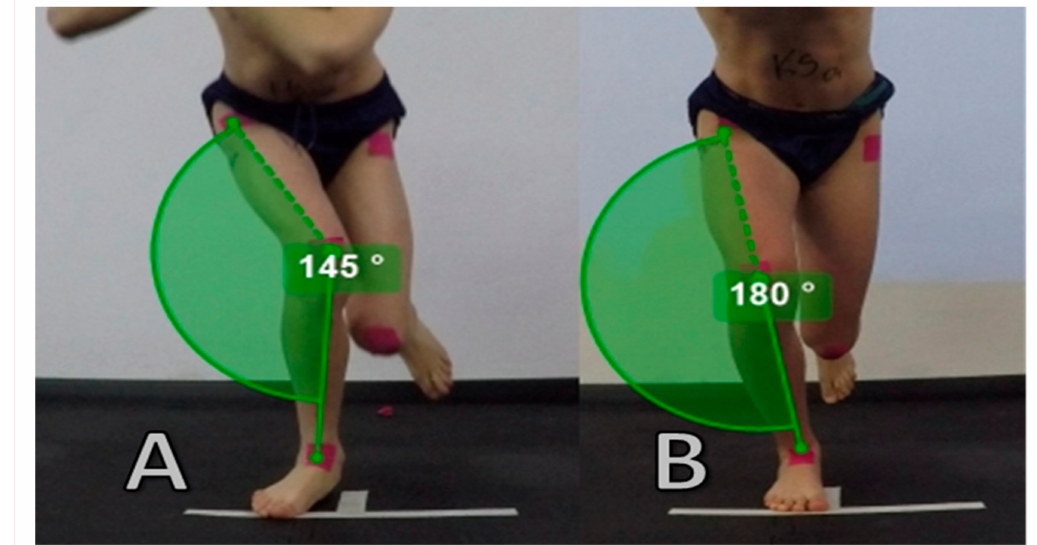
Figure 1. Example of dynamic knee valgus—knee move inwards from foot position ( A ) and correct movement pattern—knee under foot ( B ) during Single Leg Squat. Valgus quantitative assessment—angle between anterior superior iliac spine (ASIS), patella and center of malleolus ( A )—145 ◦ , ( B )—180 ◦